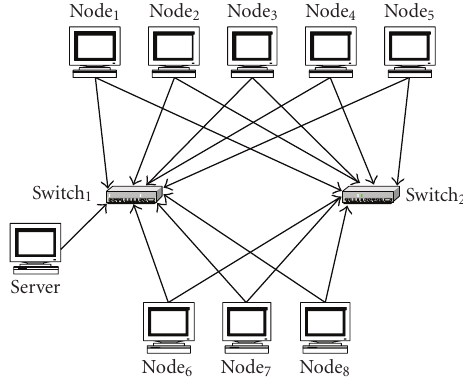
Figure 4: Network structure of the cluster.